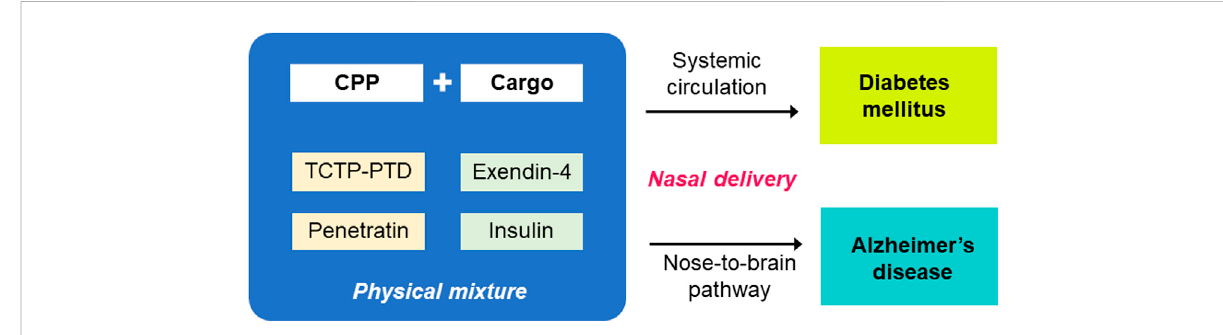
FIGURE 3 CPP-aided systemic and nose-to-brain delivery of antidiabetic peptides after nasal administration. TCTP-PTD and penetratin and variants thereof shown to be effective in the delivery of antidiabetic peptides, such as exendin-4 and insulin. The in vivo ef fi cacy of systemic and nose-to- brain delivery of nasally coadministered CPPs and antidiabetic peptides were con fi rmed in murine models of diabetic and Alzheimer ’ s disease,